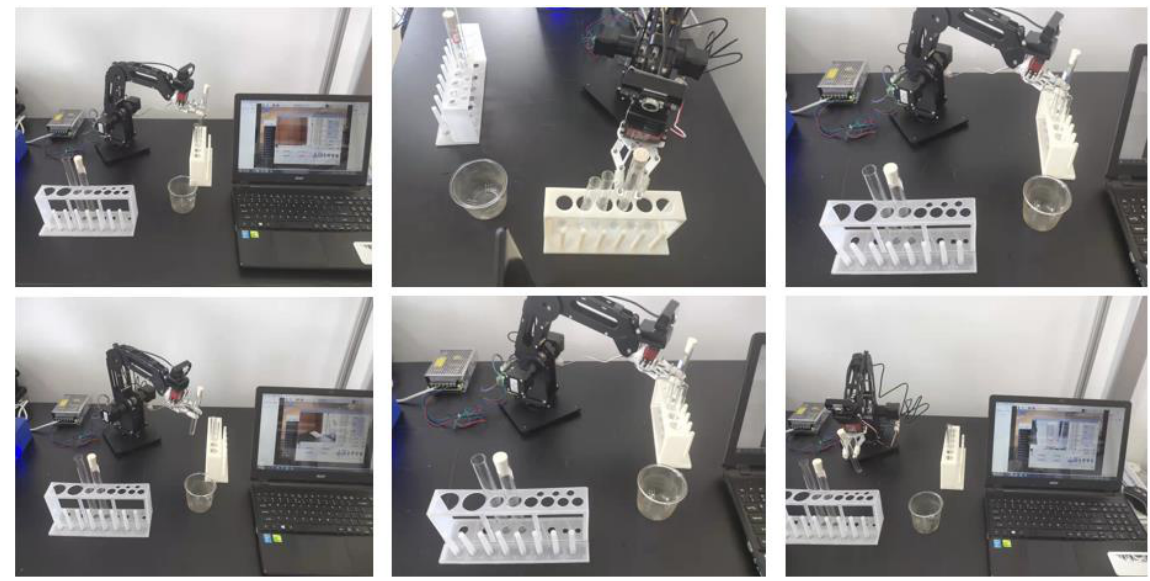
Figure 16. Experimental setup.